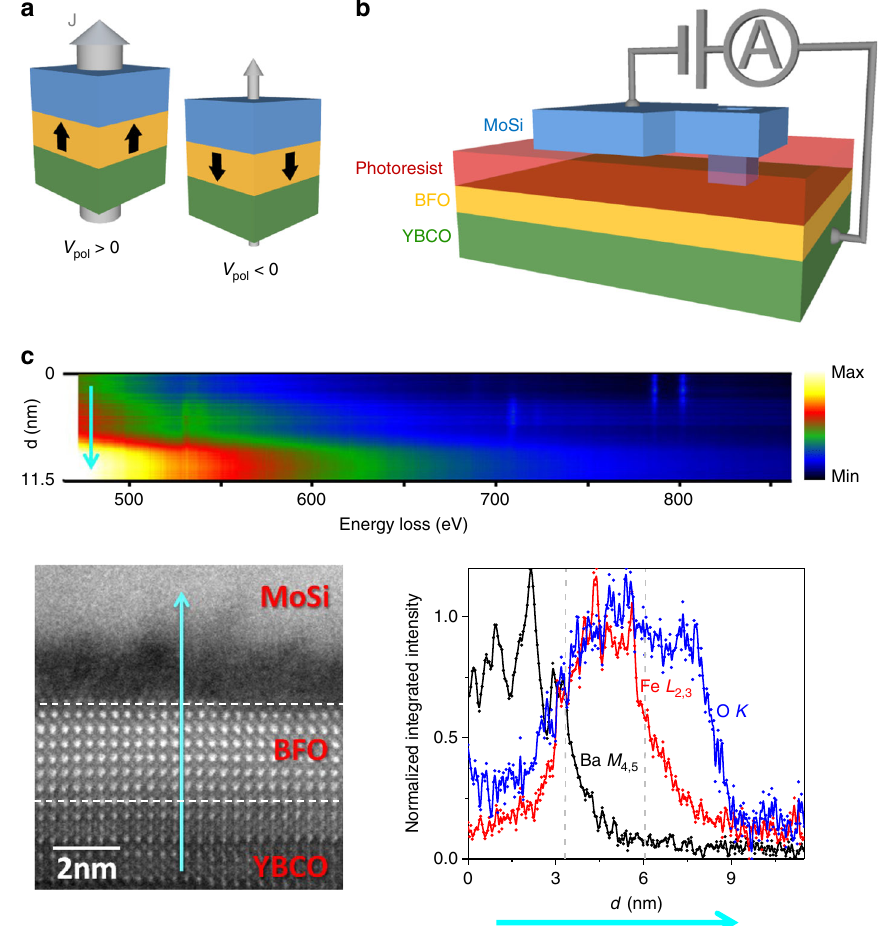
Fig. 1 Junctions ’ structure. a A tunnel junction whose barrier is ferroelectric can be reversibly switched between a high and low-conductance states by the application a voltage pulse of amplitude V pol , which sets the remnant ferroelectric polarisation direction towards one electrode or the opposite. b Scheme of a superconductor/ferroelectric/superconductor tunnel junction based on a YBa 2 Cu 3 O 7- δ /BiFeO 3 heterostructures on which a micrometric Mo 80 Si 20 contact is made through an aperture across an insulating photo-resist overlayer. c (Top) EELS linescan acquired while scanning the electron beam across the stacking, moving a distance d from the YBCO into the MoSi layer along the direction of the cyan arrow. The signal intensity is indicated by the colour scale (in arbitrary units). The edges of interest include the O K edge near 528 eV, Fe L 2,3 with onset near 709 eV or the Ba M 4,5 , near 781 eV. Principal Component Analysis was used to remove random noise. (Bottom, left) Atomic resolution HAADF image of the YBCO/ BFO/ MoSi stack. Then horizontal dashed lines highlight the approximate locations of the BFO top and bottom interfaces (Bottom, right) Normalised integrated intensities for the O, Fe and Ba signals in blue, red and black, respectively. The vertical dashed lines highlight the approximate locations of the BFO top and bottom interfaces. In all panels a cyan arrow shows the direction of the